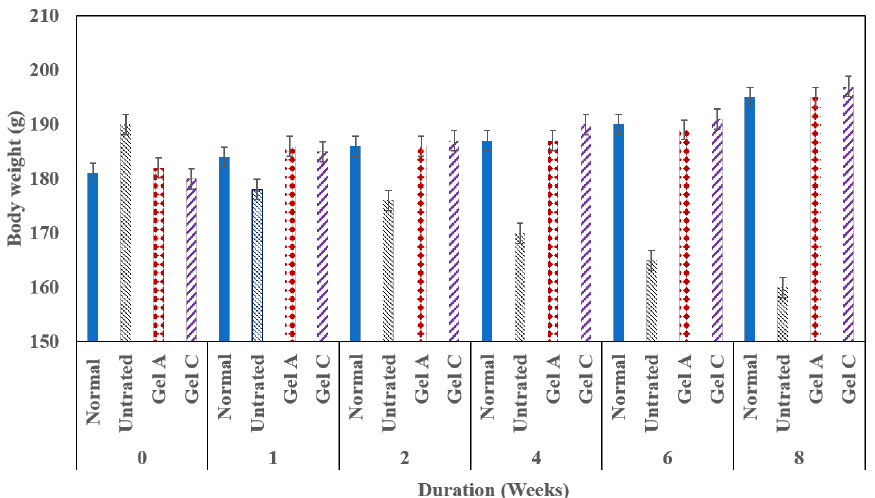
Figure 9. The effect of the modified hydrogel systems (A and C) loaded with dual anticancer (5-FU/MTX) on the body weight of rats in comparison with untreated animals.